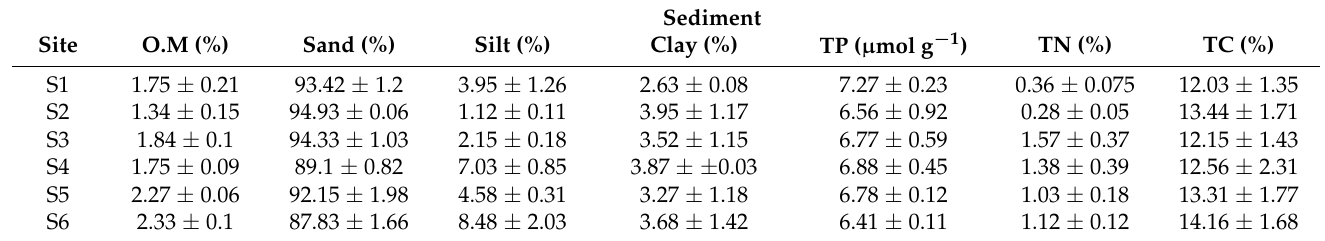
Table 2. Physicochemical characteristics, organic matter content (O.M%) and elemental analysis (nitrogen and carbon) for sediments of sampling sites. Average values and standard deviations were